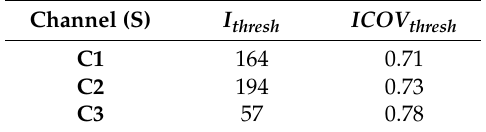
Table 5. Threshold values I thresh and ICOV thresh for the three